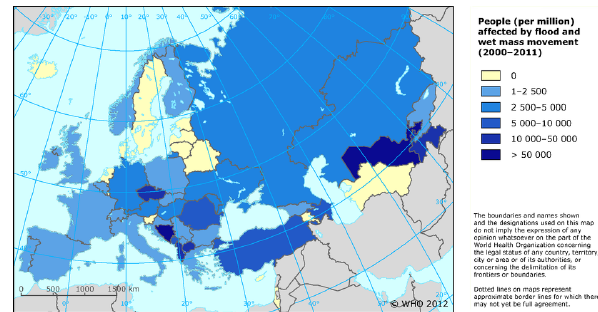
Figure 4. People affected by flood events in Europe in the pe- riod 2000–2011, per million population (WHO European Re- gion). Source: http://www.eea.europa.eu/legal/copyright). Copy- right holder: World Health Organization Regional Office for Europe